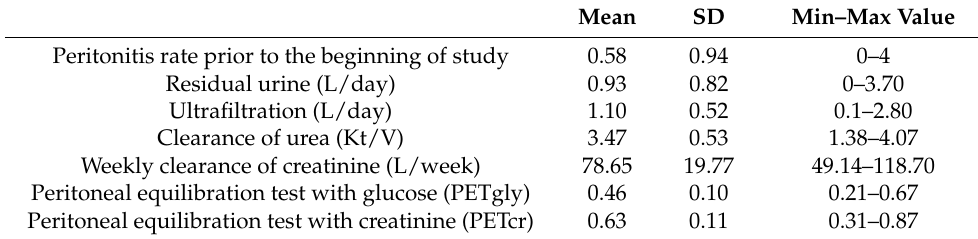
Table 1. Dialysis characteristics and dialysis efficiency in patients on peritoneal dialysis ( n = 52). Mean SD Min–Max Value Peritonitis rate prior to the beginning of study 0.58 0.94 Residual urine (L/day) Ultrafiltration